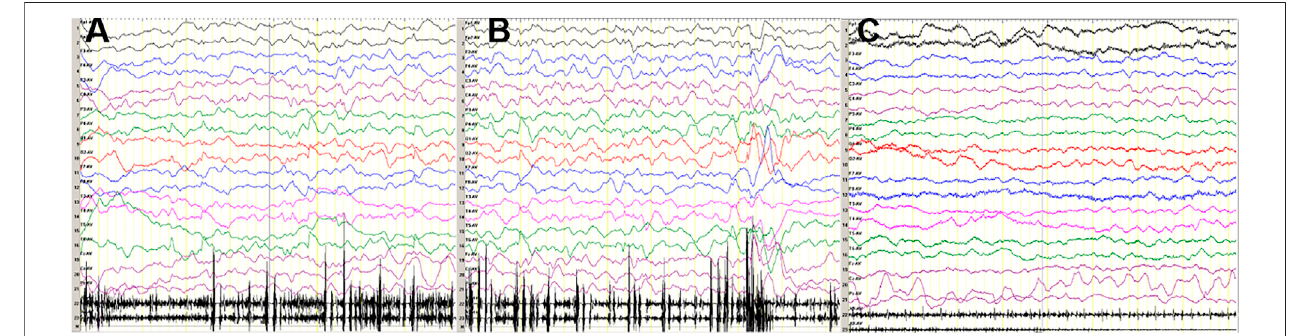
FIGURE 1 | (A, B) At the age of 3 months, sleep EEG of the patient revealed multifocal sharp waves and low waves. (C) Wake EEG was